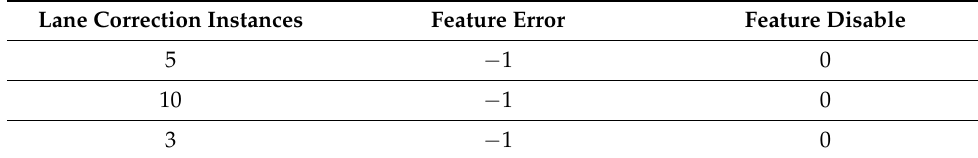
Table 2. Data collection spreadsheet for test drivers.